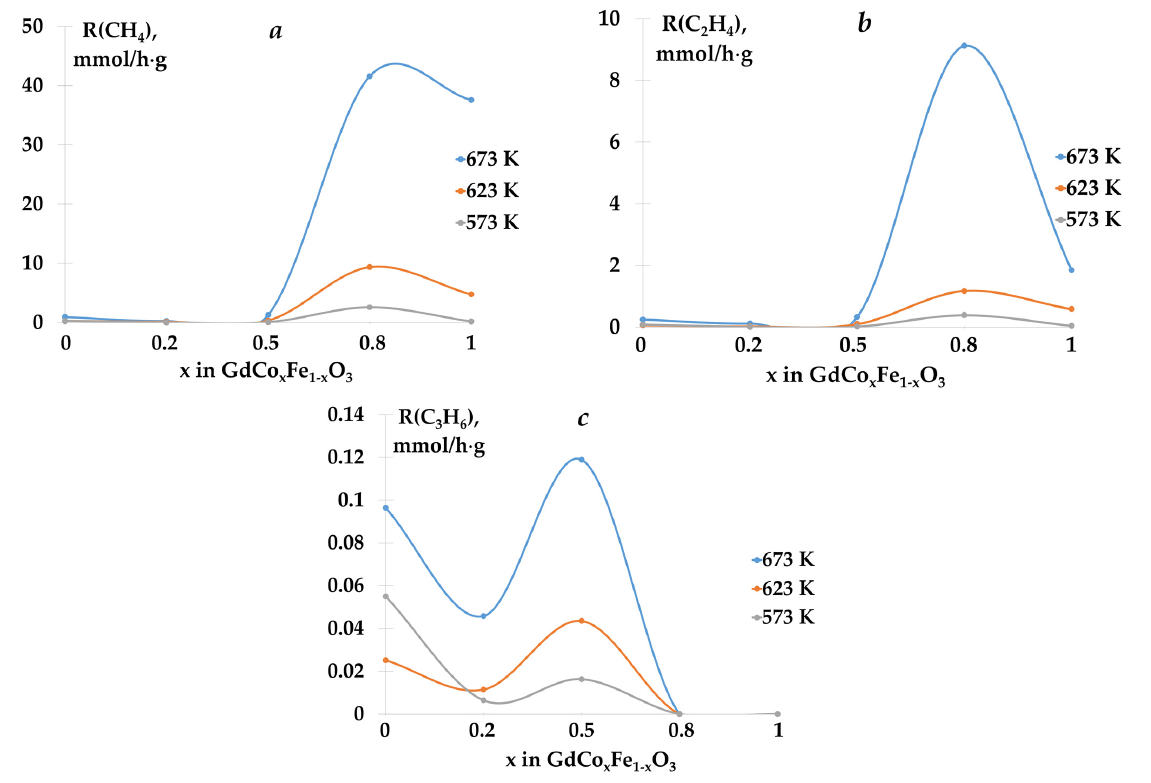
Figure 7. Temperature dependences of (a) methane, ( b ) ethylene and ( c ) propylene formation rates on GdCo x Fe 1-x O 3 catalysts. on GdCo x Fe 1 − x O 3